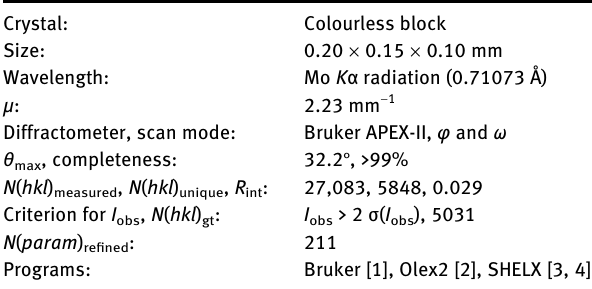
Table  : Data collection and